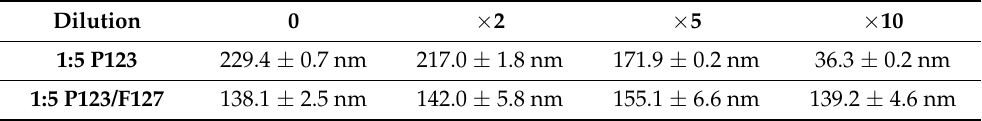
Table 5. Changes of naringenin ‐ loaded particle size against dilution with distilled water. Dilution